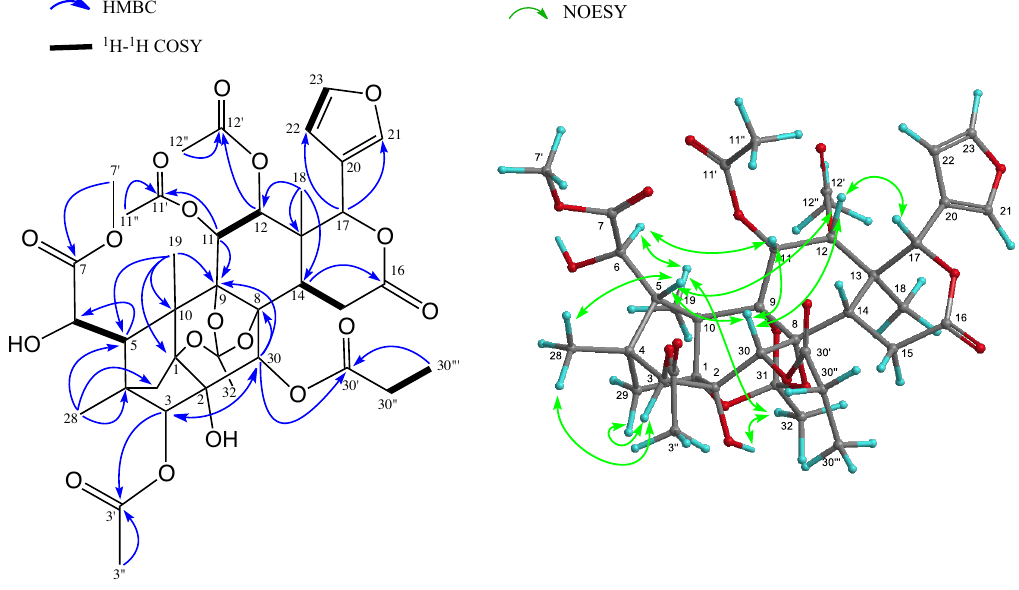
Figure 4. Key HMBC, COSY and NOESY correlations for carapanolide X ( 5